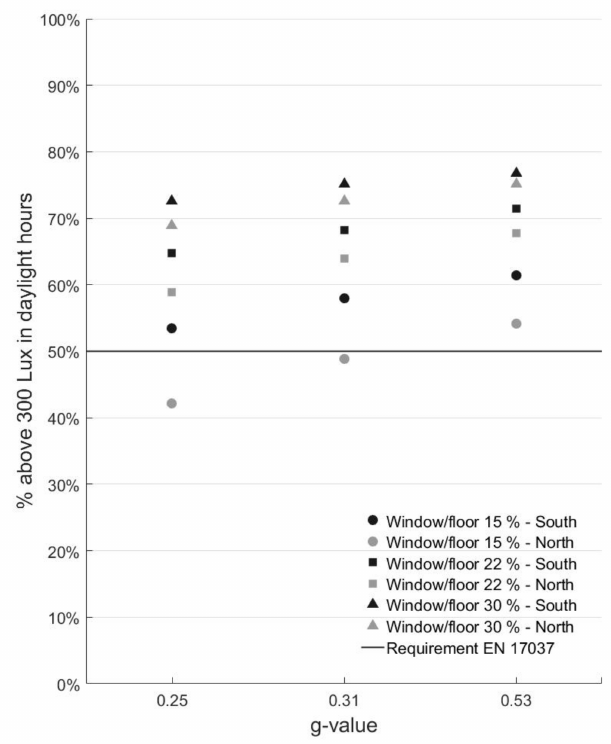
Figure 6. Percentage of daylight hours above 300 Lux on 50% of the reference plane in all room